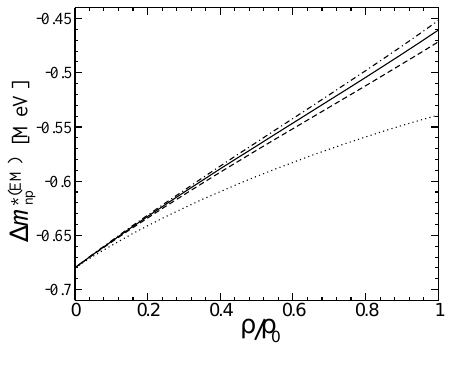
Fig. 7. Density dependence of the electromagnetic part ∆ m ∗ (EM) np of the neutron-proton mass di ff erence in nuclear matter. The axes and curves are defined as in Fig. 6. Figure from Ref. [43].